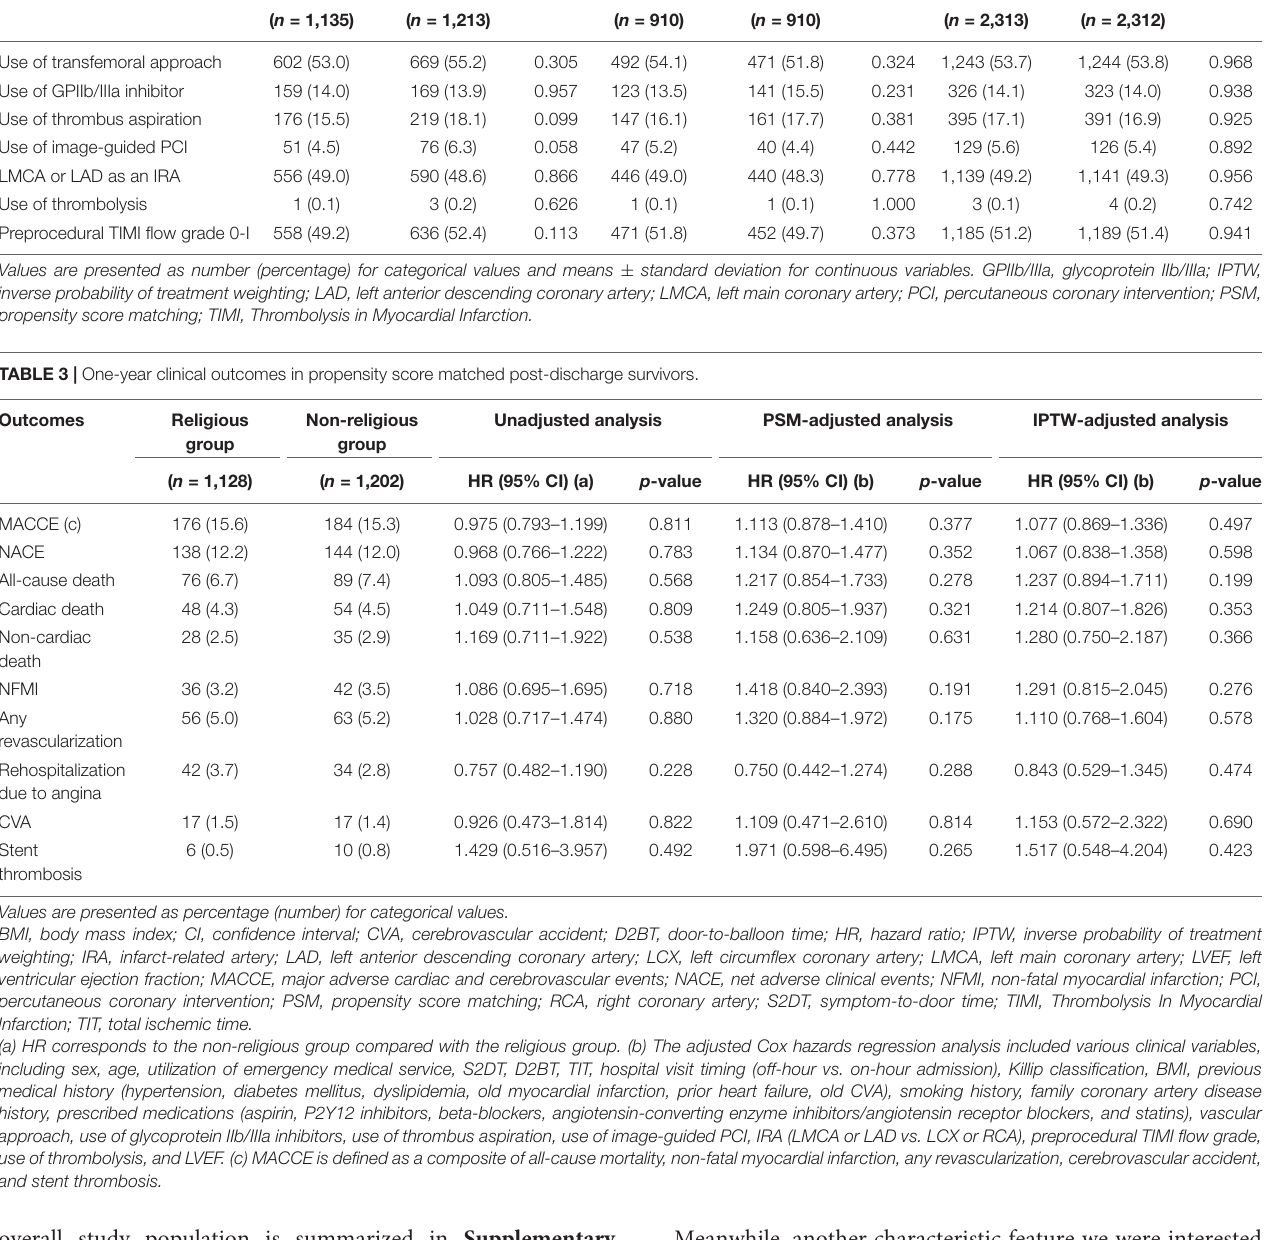
Table 1 . Patients with AMI aged < 60 years were more prevalent in the non-religious group, while sexagenarian, septuagenarian, octogenarian, and nonagenarian patients were more predominant in the religious group. Therefore, the lower prevalence of hypertension in the non-religious group is best explained by the fact that hypertension is less prevalent in young ages, according to a study by Kang et al.